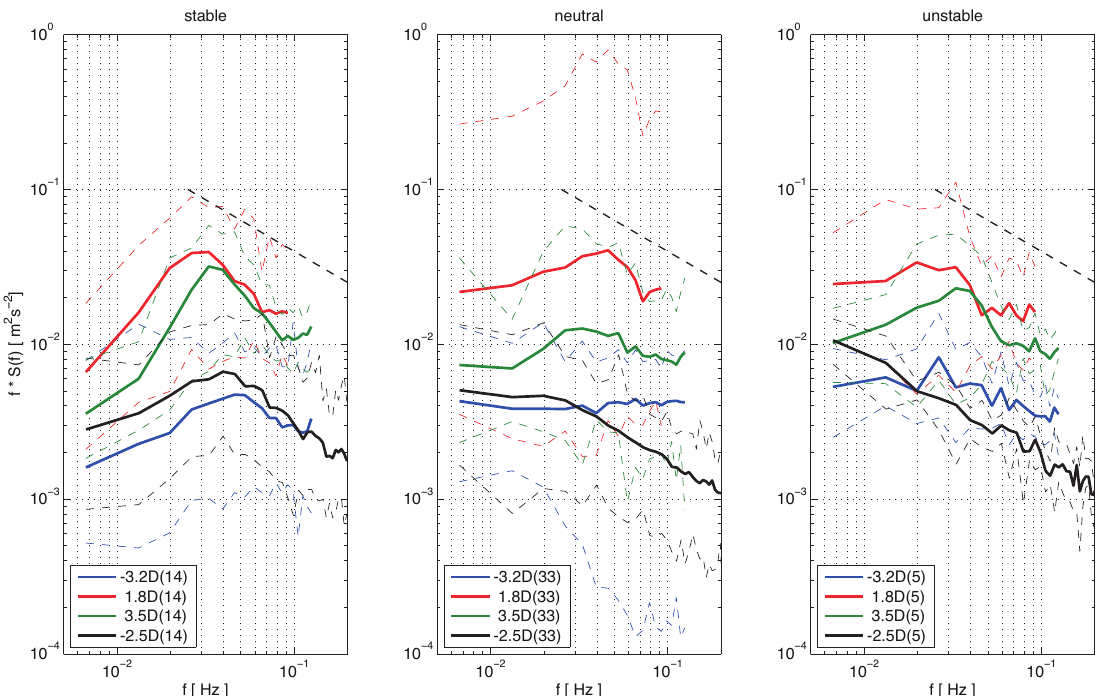
Figure 10. Composites of normalized hourly energy spectra u / u mean at 80m for wind directions between 210 ◦ and 220 ◦ under stable (left), neutral (center) and unstable (right) conditions. Dashed lines show maximum and minimum values of the data bin. Data from the upstream sonic and Windcube wls67 are illustrated in black and blue, while downstream Windcubes wls37 and wls65 are illustrated in red and green, respectively. The legend shows additionally the number of averaged hours in parentheses. The thick dashed line indicates the − 2/3 Kolmogorov